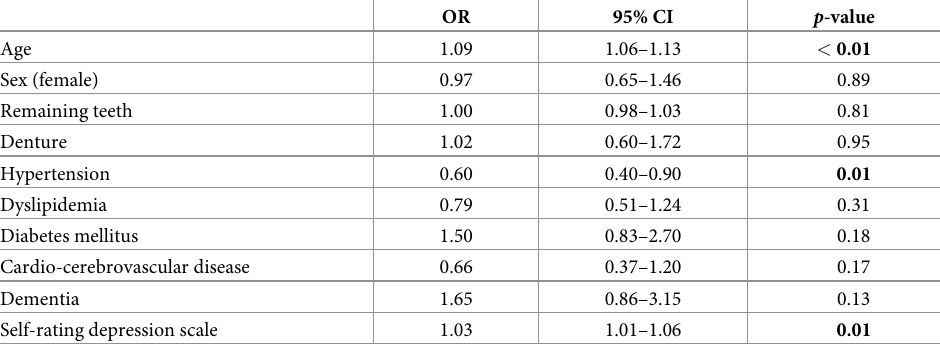
Self-rating depression scale 1.03 1.01–1.06 0.01 Note. Objective variables were scored as robust = 0, pre-sarcopenia and sarcopenia combined group = 1. Chronic diseases: no = 0, yes = 1.